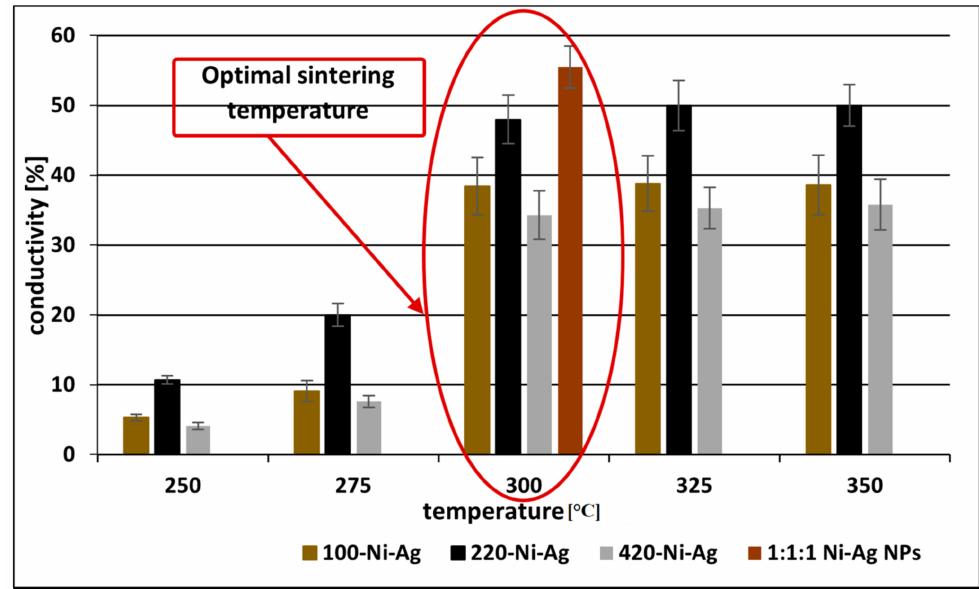
Figure 9. The dependence of the conductivity (in comparison to bulk nickel) of metallic films based on Ni-Ag NPs with different average sizes and their mixture (at 1:1:1 weight ratio) on the temperature of sintering (30